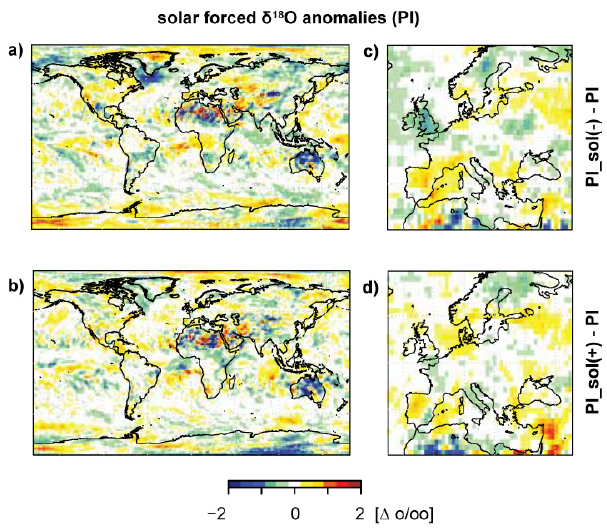
Fig. 5. Same as Fig. 4 but for δ 18 O in precipitation